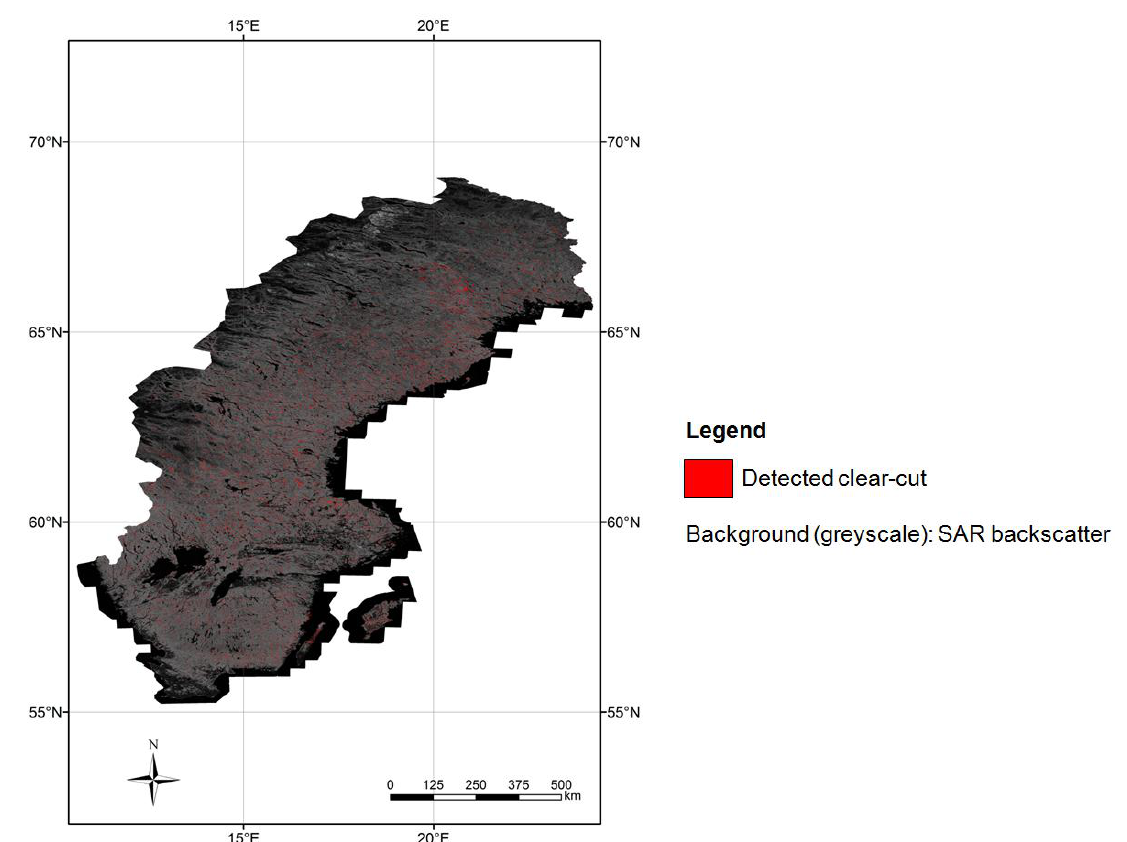
Figure 5. Map of detected clear-cuts (in red) from ALOS PALSAR K&C strip data for the time period 2008–2009 overlaid on a mosaic of the average HV-backscatter images acquired during 2009.